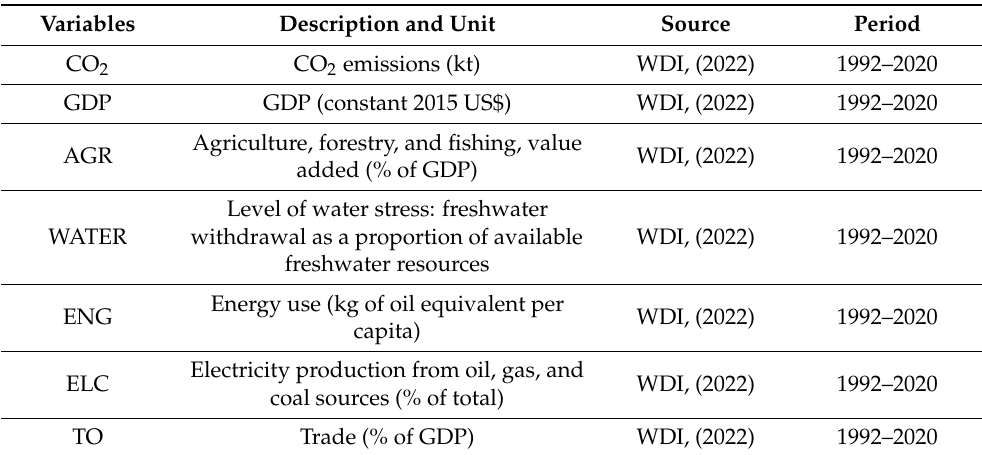
Table 1. Source of data and description of